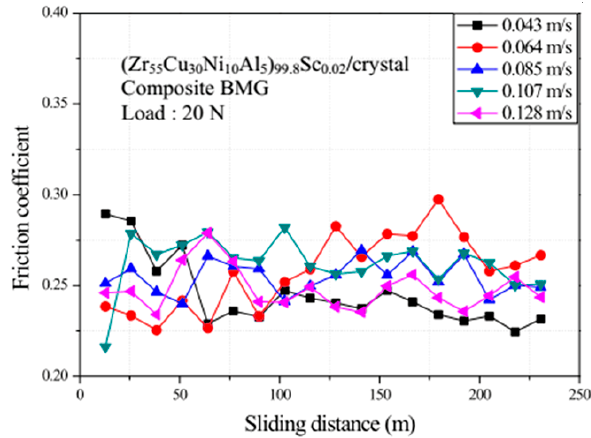
Figure 3. A plot of variation in friction coefficients at different sliding velocities under a 20 N load versus sliding distance.